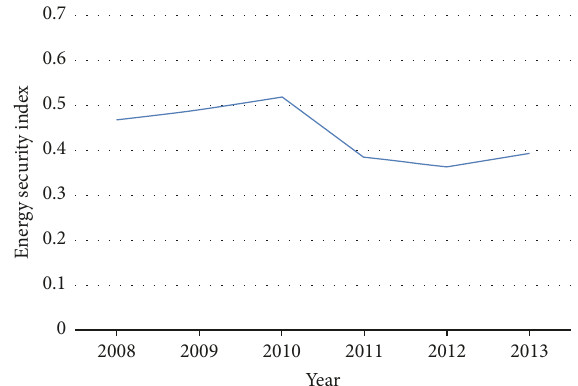
Figure 3: Japan’s energy security from 2008 to